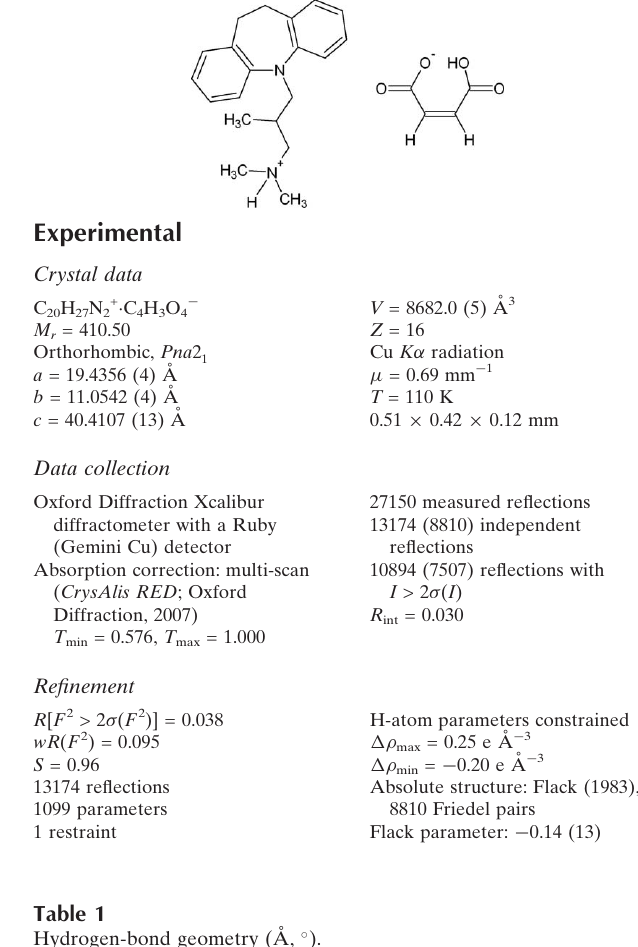
Hydrogen-bond geometry (A˚ , (cid:4)